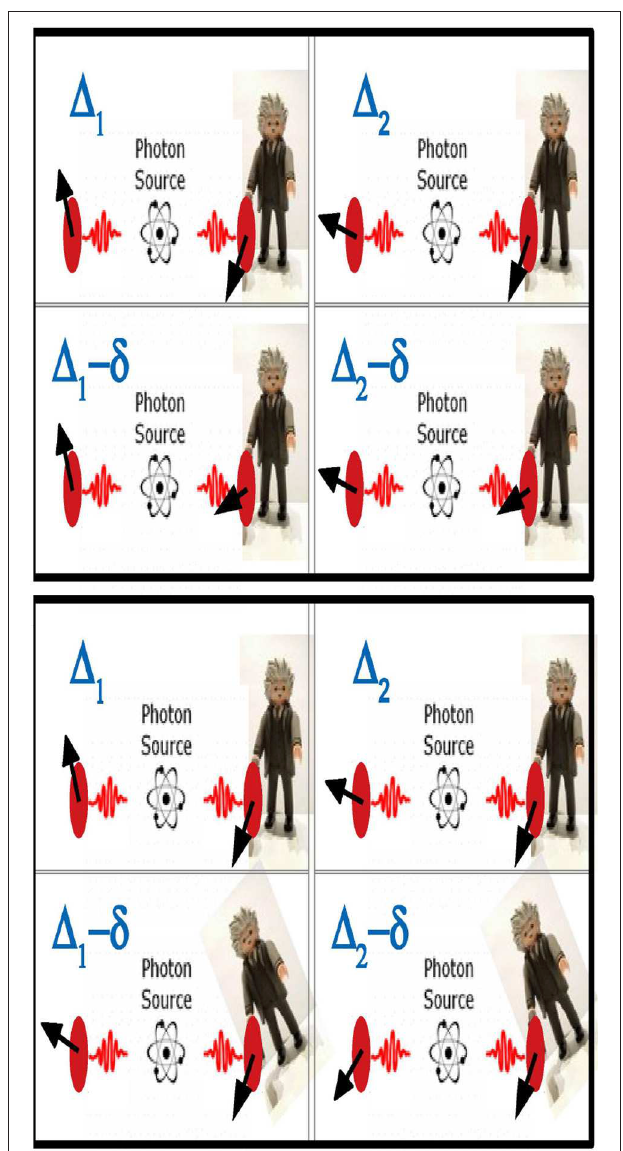
FIGURE 2 | Two descriptions of the experimental setup required for testing the Bell inequality. In the description above the lab frame is taken to be fixed, while in the description below the orientation of detector A is taken to be fixed. The relative angle between the two detectors is set at four possible values 1 1 , 1 2 , 1 1 δ , and 1 2 δ . When considering models in which the hypothetical − − hidden configurations of the pairs of entangled particles spontaneously break the symmetry under rigid rotations of the orientations of the two measurement devices, only the latter choice allows to properly compare the four